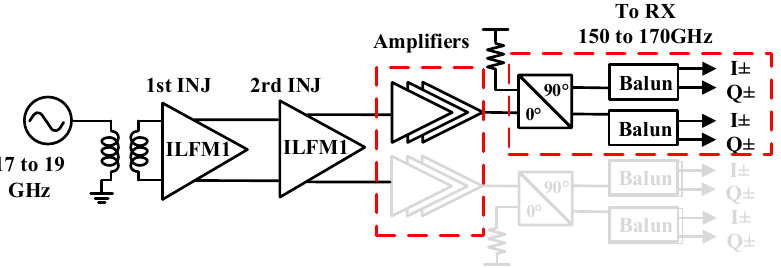
Figure 5. Simulation results of quadrature mixer.